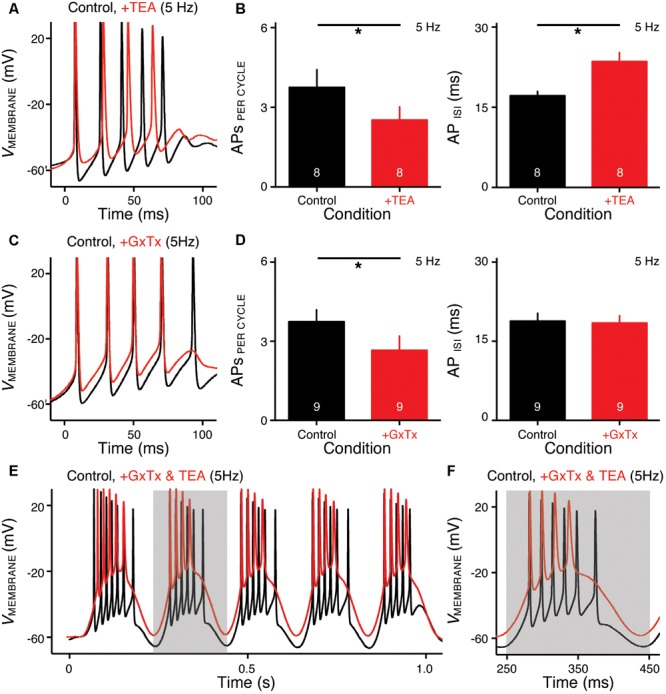
KV2- and KV3-containing channels regulate burst firing for NMc neurons. (A,C) Representative voltage responses to the first cycle of 5 Hz sinusoidal current injections in control (black) and during the application (red) of TEA (A) or GxTx (C). TEA, tetraethylammonium (1 mM). GxTx, Guangxitoxin (100 nM). (B,D) Population data showing APs per cycle and inter-spike interval (ISI) in response to 5 Hz sinusoidal current injections, in control and during the application of TEA (B) or GxTx (D). Error bar = standard error. Numbers in bars represent sample size. ∗p < 0.05. (E,F) Representative voltage responses recorded from an NMc neuron to 5 Hz sinusoidal current injections in control (black) and during dual drug application (red) of GxTx and TEA. Gray area of the second sinusoidal cycle in (E) was expanded and shown in (F).